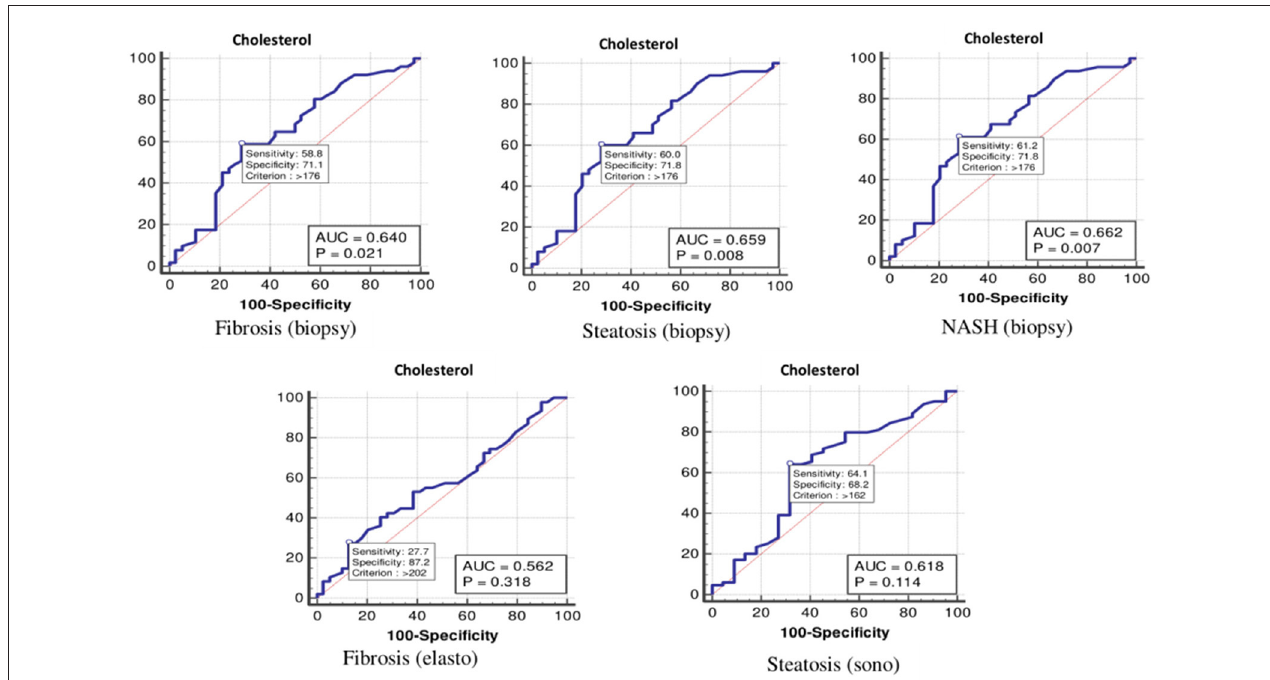
FIGURE 1 | The receiver operating characteristics curve for cholesterol in the detection of liver disease.